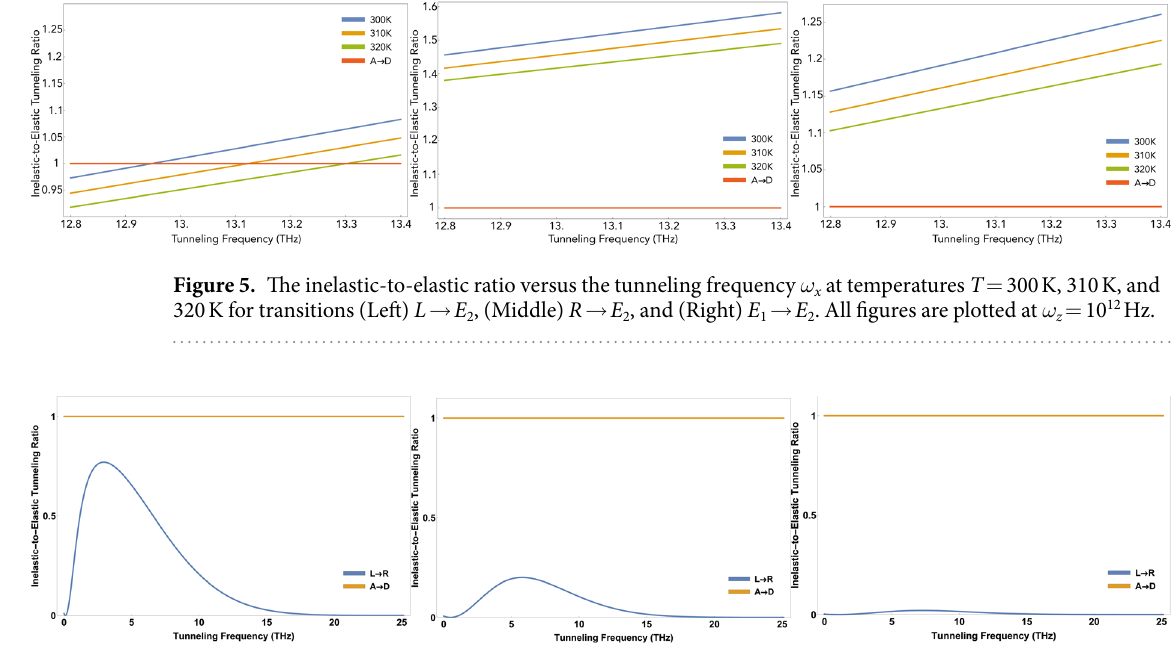
Figure 6. The inelastic-to-elastic ratio versus the tunneling frequency ω x in the high-pressure limit for transition DR → AL for (Left) ω z = 1 THz, (Middle) ω z = 5 THz, and (Right) ω z = 10